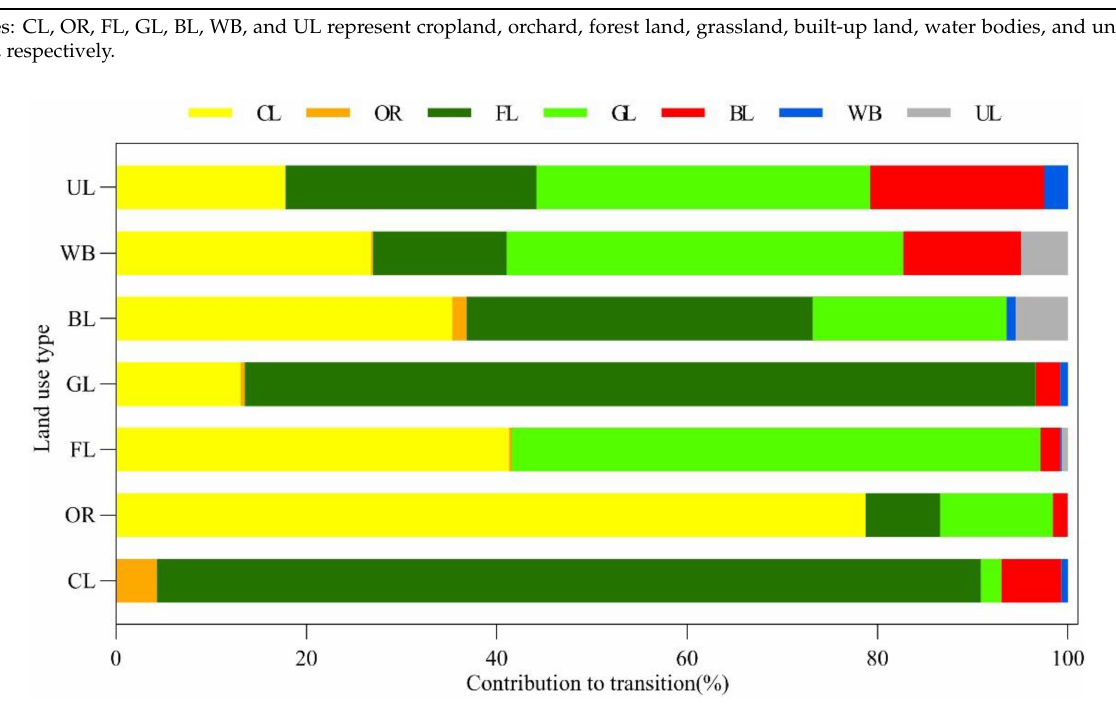
Figure 3. Internal conversions between land use types and contributions to land use transition. Notes: CL, OR, FL, GL, BL, WB, and UL represent cropland, orchard, forest land, grassland, built-up land, water bodies, and unused land,